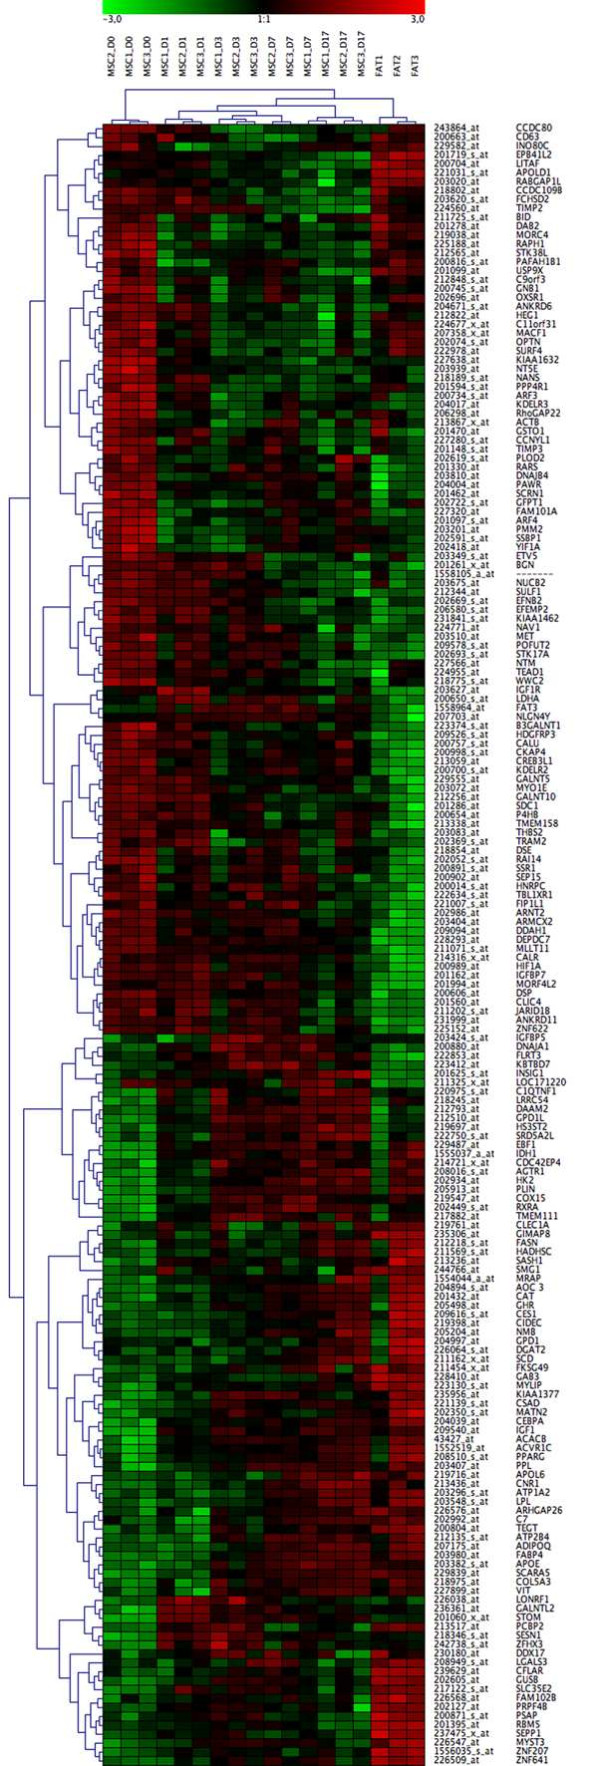
Hierarchical cluster analysis of adipogenic gene expression profile. Hierarchical cluster analysis of the 184 candidate genes (85 with increased expression, 99 with decreased expression) selected as relevant by SiPaGene. Clustering of genes and experiments resulted in two main groups, namely undifferentiated MSC at day 0 and all other experiments. The latter main group was subdivided in the native fat tissue group and the group of adipogenic induced MSC at day 1, 3, 7 and 17. The MSC group was further divided in two groups: in the first, we found all MSC cultures induced for 1 and 3 days (early adipogenesis) and 2 out of 3 MSC cultures induced for 7 days. In the second subgroup, we observed all MSC cultures stimulated for 17 days (later adipogenesis) and the third day 7 culture (see also the dendrogram). Colours represent relative levels of gene expression: bright red indicates the highest level of expression, and bright green indicates the lowest level of expression. On the right site gene names are included.